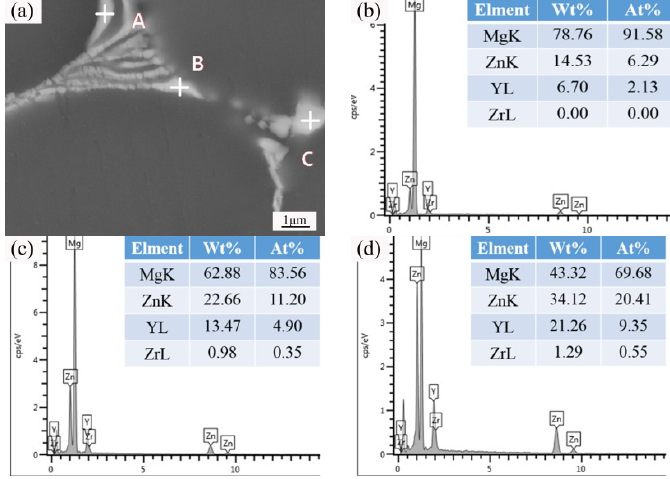
Figure 13. The SEM microstructure ( a ) and EDS analysis of the isothermal forging parts at 380 °C: ( b ) Spot A, ( c ) Spot B, ( d ) Spot C. Table 7. Atom ratios (at%) for different elements of each spot in Figure 13a.